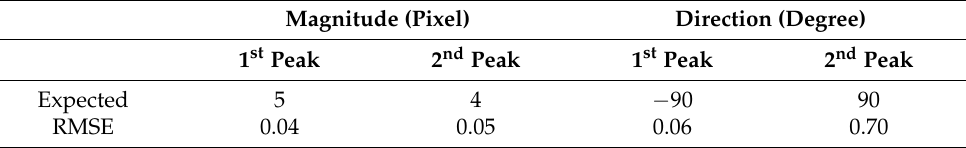
Figure 4. Plots in top panel are the instantaneous velocity maps corresponding to ( a ) 1st peak and ( b ) 2nd peak; and plots in bottom panel are the time-averaged velocity maps corresponding to the ( c ) 1st peak and ( d ) 2nd peak. Table 1. Summary of expected value and RMSEs in magnitude and direction from the validation result with synthetic images. Note that time-averaged results are used in error estimation.